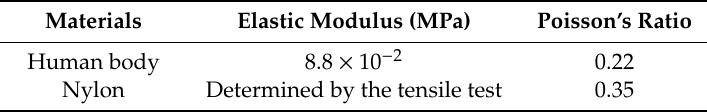
Figure 2. The 3D finite element meshed models. ( a ) The human body model, ( b ) the whole finite elements model, and ( c ) the BSC model. Table 2. Mechanical properties of different materials of the model